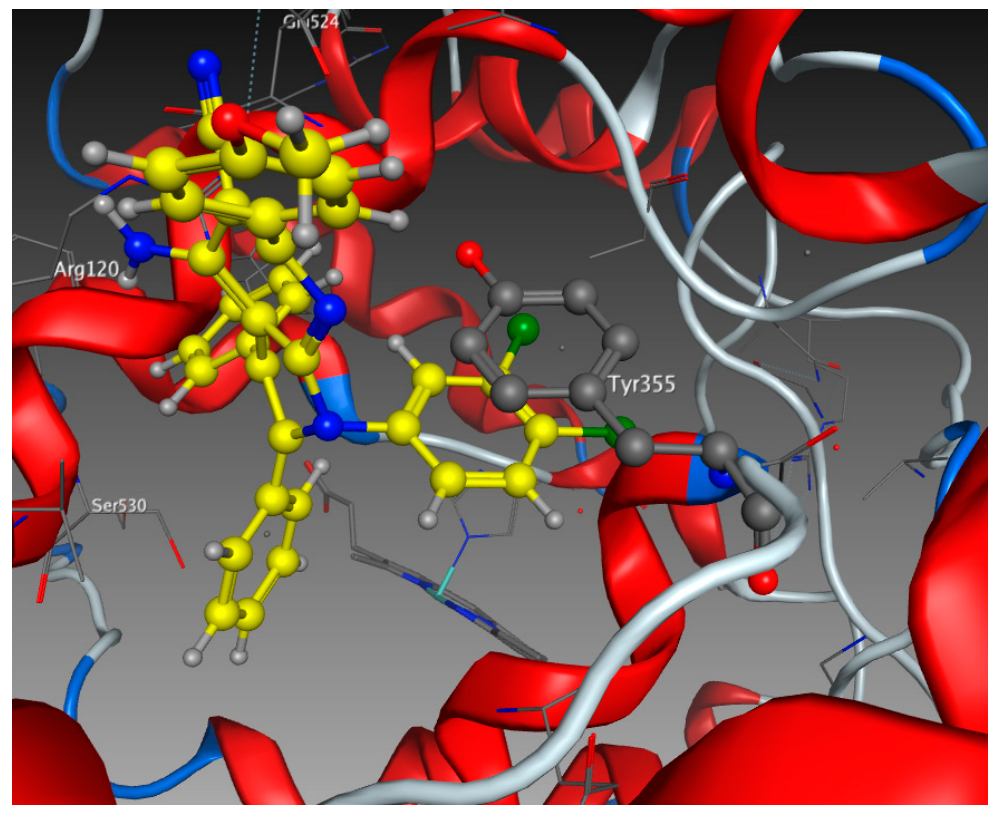
Figure 3. The best binding mode of compound 3j .